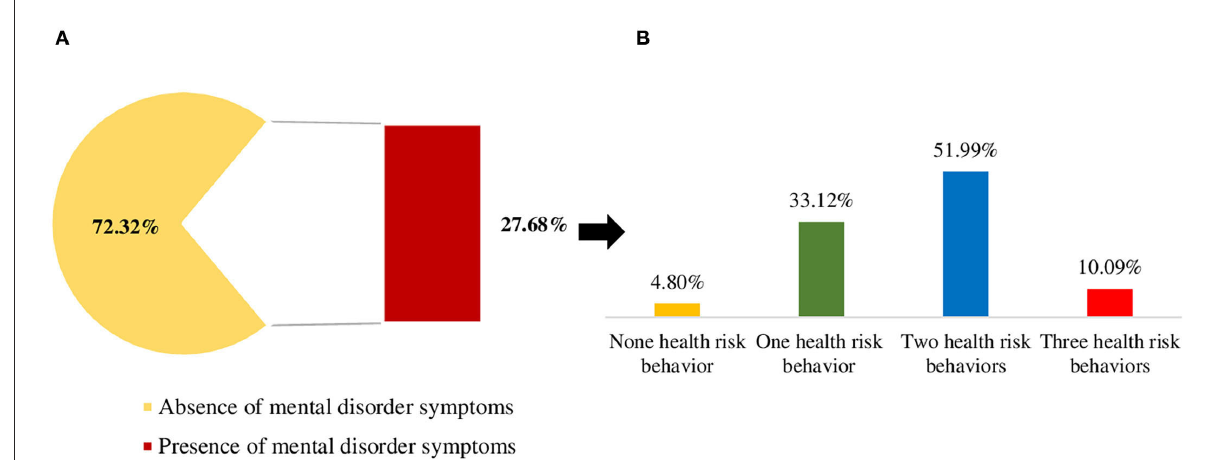
FIGURE3 Prevalence of health risk behaviors among individuals with symptoms of anxiety or depression, COVID Inconfidentes 2020. (A) Prevalence of mental disorder symptoms. (B) Prevalence of the combined occurrence of health risk behaviors among those with mental disorder symptoms. The health risk behaviors: sedentary behavior ( ≥ 9 h/day), non-daily consumption of fruits and vegetables, and high weekly consumption of ultra-processed foods ( ≥ 15.15 times per week).